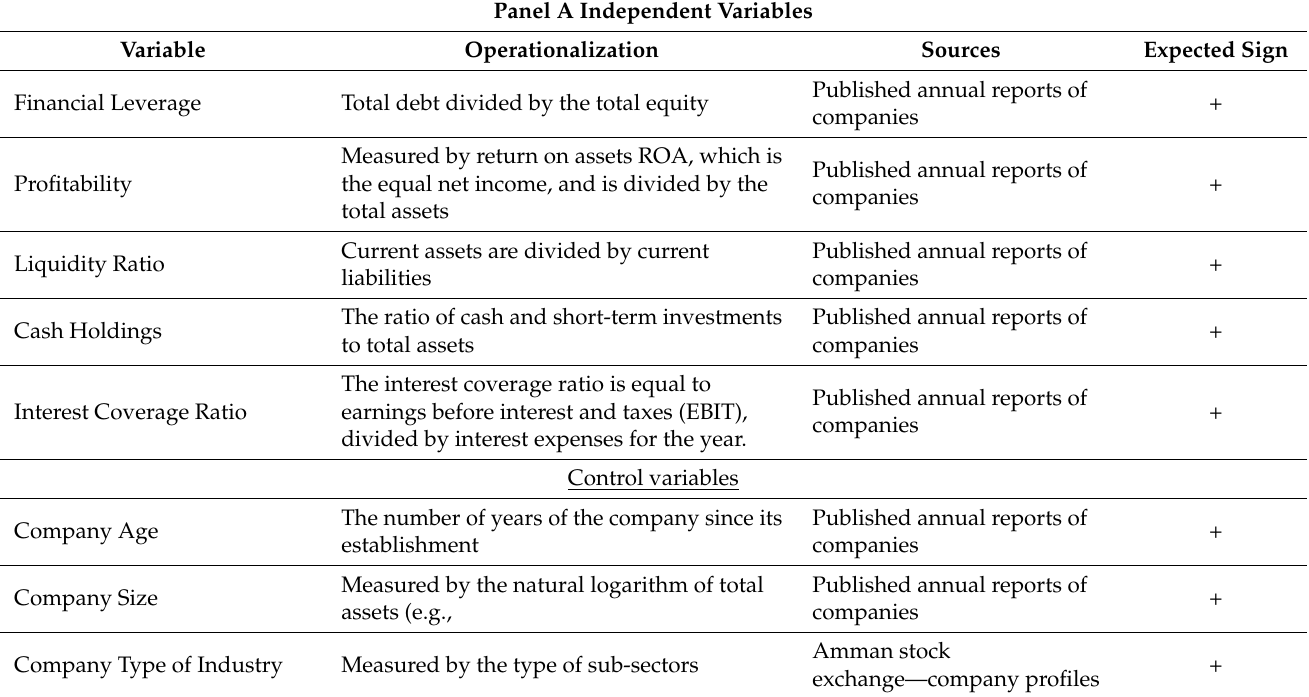
Table 1. The study variables measurement.